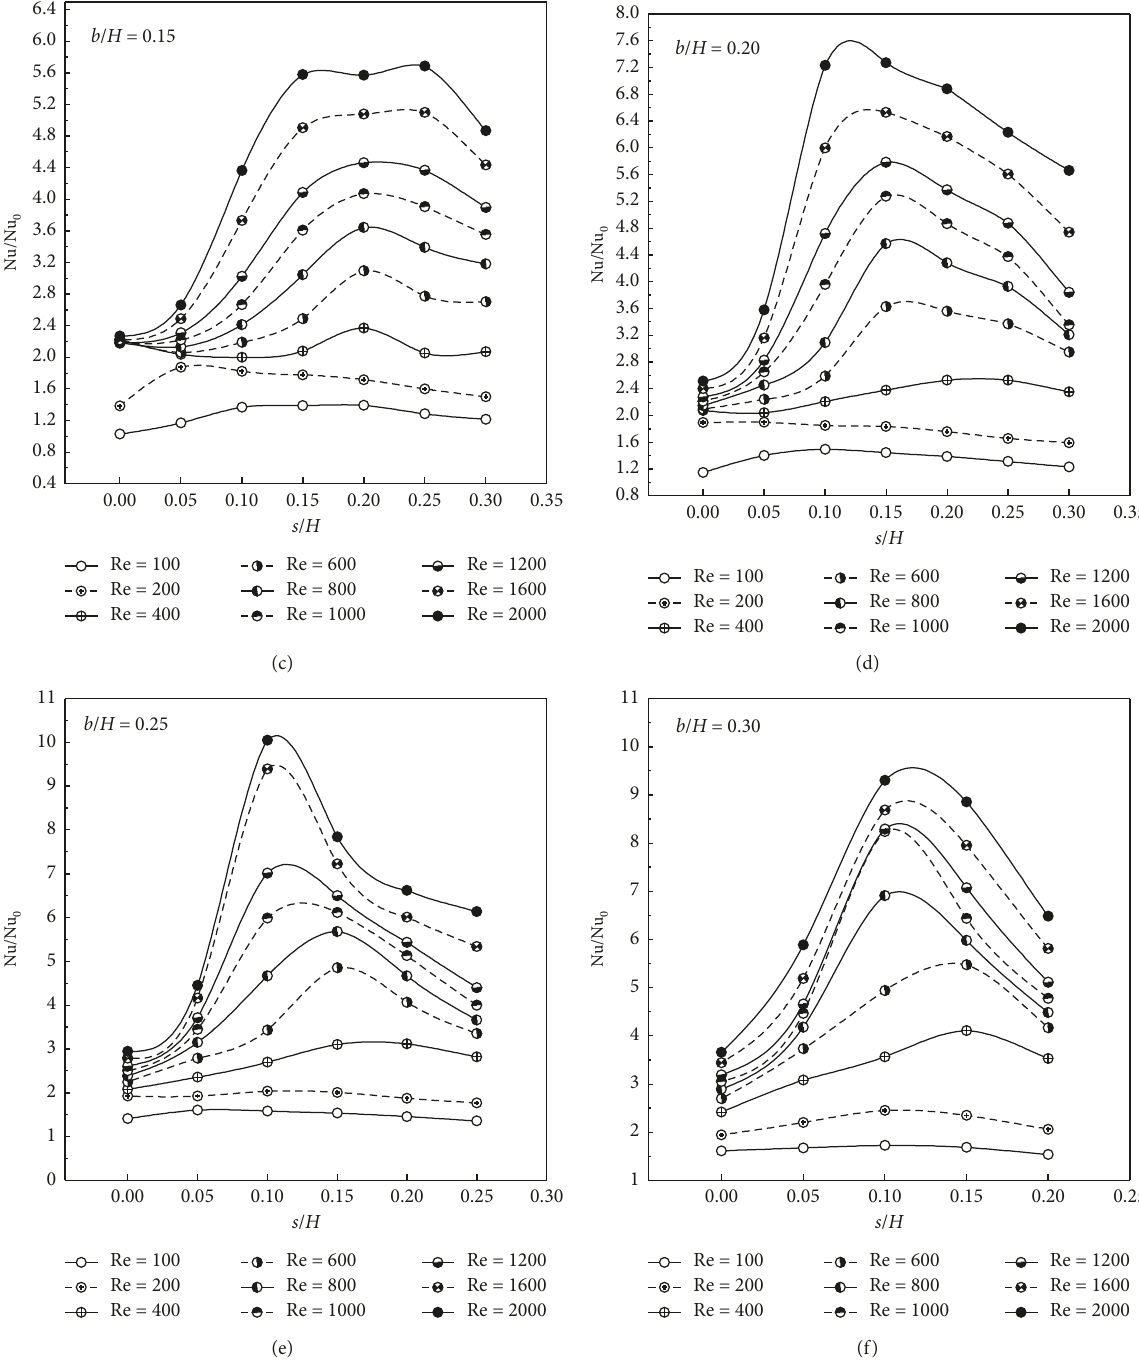
Figure 19: Nu/Nu 0 versus s / H for the heat exchanger square duct installed with the 45 (d) b / H 0.20, (e) b / H 0.25, and (f) b / H (cid:31) (cid:31)